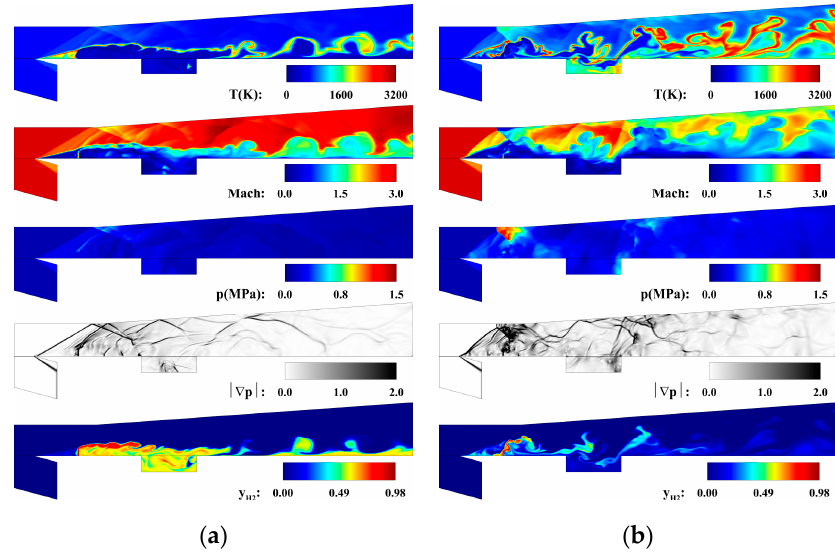
Figure 2. Instantaneous result for diverging nozzle combustor with cavity based on the injection pressures: ( a ) 0.75 MPa and ( b ) 1.00 MPa. Energies 2020 , 13 , x FOR PEER REVIEW